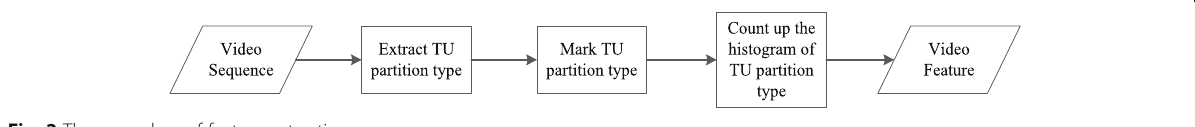
Fig. 2 The procedure of feature extraction